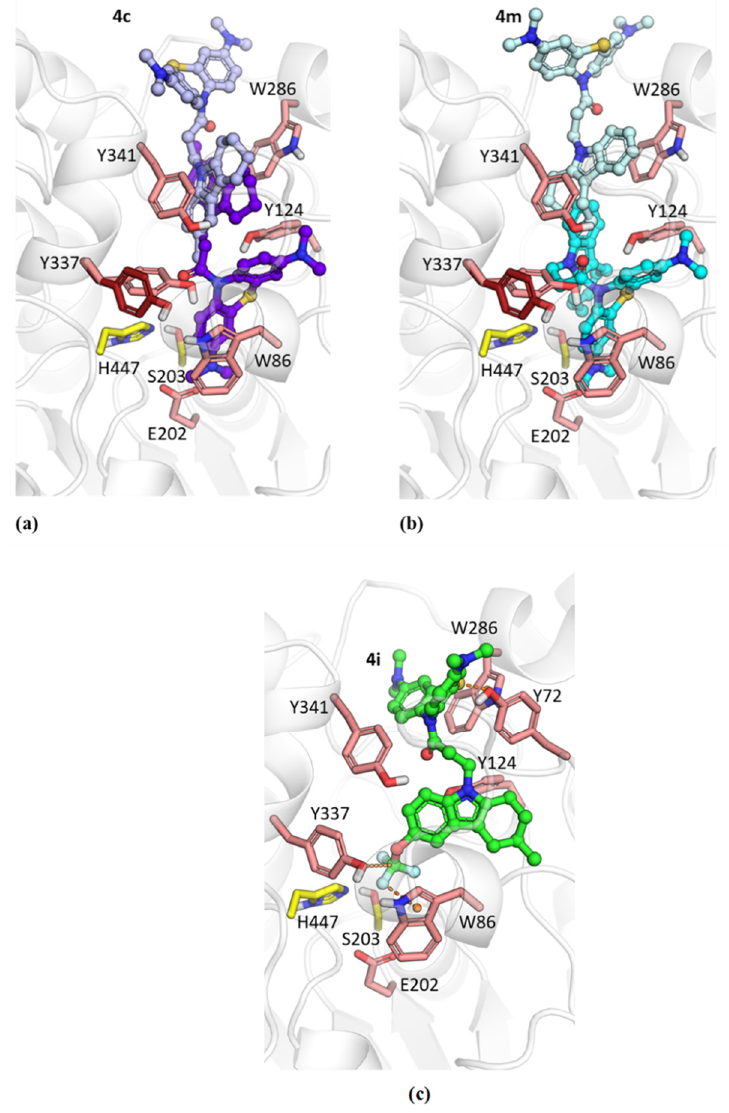
Figure 2. Docked positions of compounds 4c ( a ), 4m ( b ) and 4i ( c ) in hAChE. The position in the PAS (carbon atoms are colored light purple for 4c and light cyan for 4m ) was obtained with the PDB ID 4EY4 structure as a target. The position in the CAS (carbon atoms are colored purple for 4c and cyan for 4m ) was obtained with the PDB ID 4EY7 structure as a target. The conformation for Tyr337 in PDB ID 4EY7 differing from the PDB ID 4EY4 conformation is shown with dark red carbon atoms. The catalytic residues His447 and Ser203 are shown with yellow carbon atoms. ( c ) The position of compound 4i docked into the PDB ID 4EY7 structure (carbon atoms are colored green).